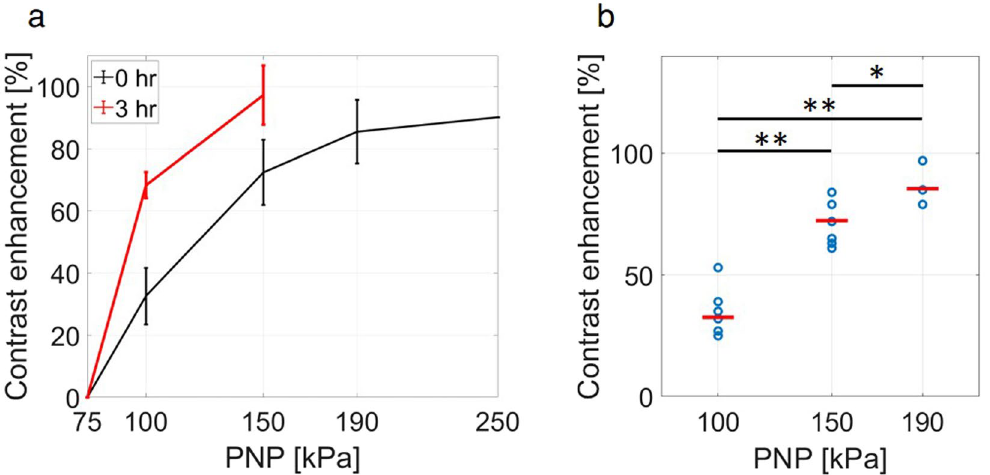
Figure 8. Contrast enhancement observed using magnetic resonance imaging (MRI). ( a ) Contrast enhancement as a function of ultrasound peak negative pressure (PNP) at 0 and 3 hours post treatment. ( b ) Contrast enhancement increases with the PNP of the therapeutic ultrasound pulse at 0 hours post treatment. * Indicates p < 0.05, and ** indicates p <